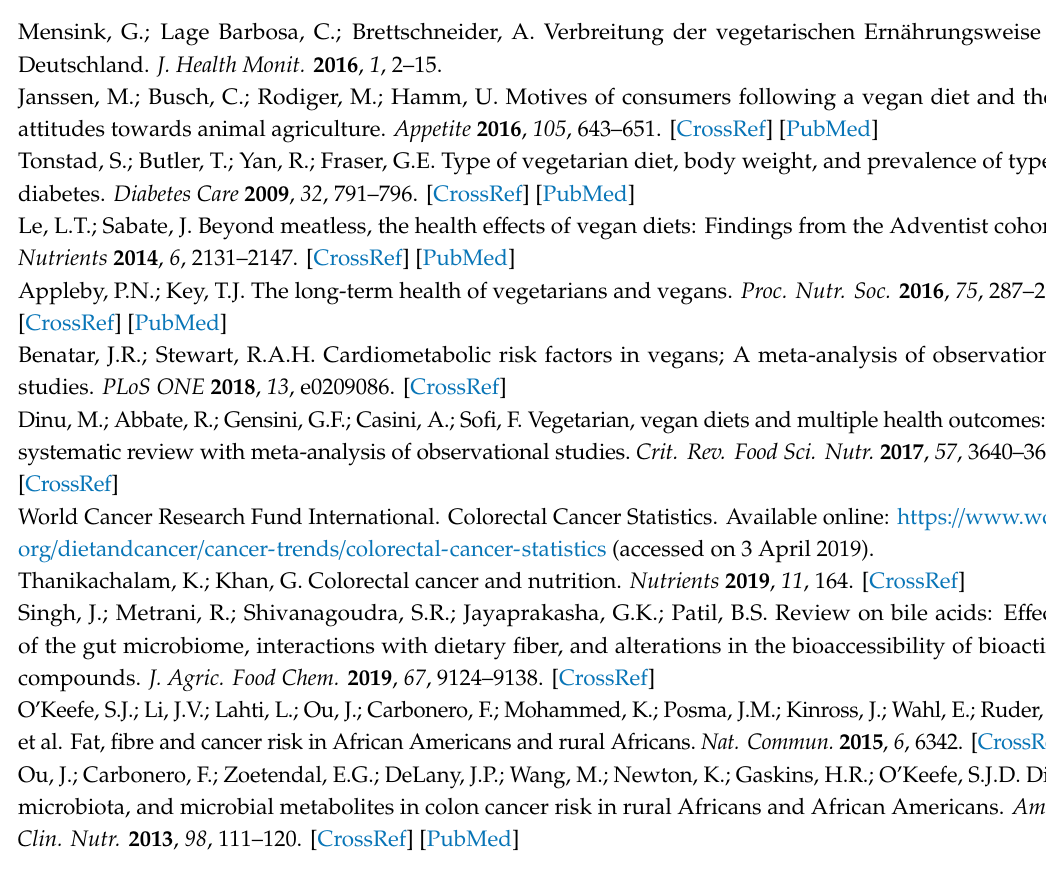
Table S1: Yielding factors for prepared food items; Table S2: Definition of food groups; Table S3: Intake of food groups of RBVD population; Table S4: Factor loadings of all 53 food groups in first dietary pattern score; Figure S1: Study flow